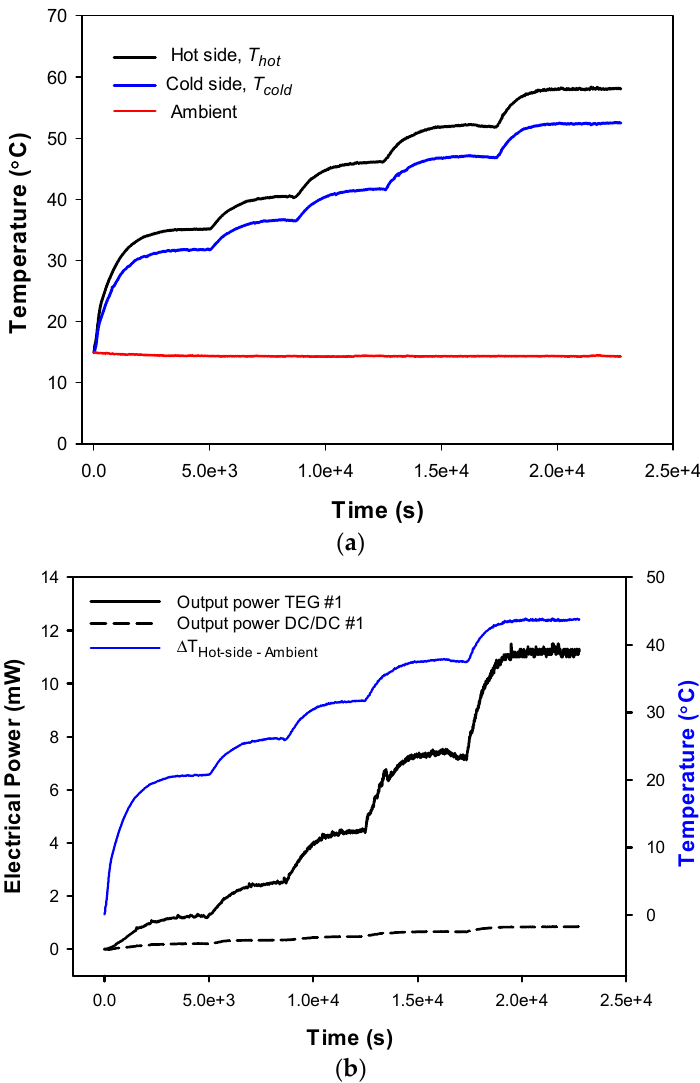
Figure 8. ( a ) Hot side, heat sink and ambient temperatures measured by T-type thermocouples. ( b ) Electrical output power of TEG and DC/DC converter, and temperature difference between hot side and ambient.